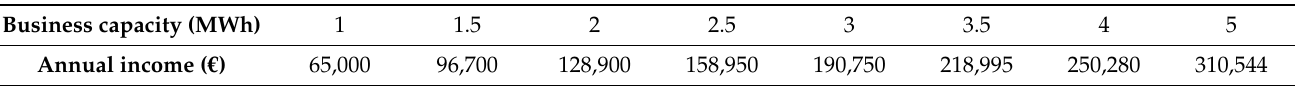
Table 8. Final revenues for 2020 depending on the free commercial capacity of the repository. Business capacity